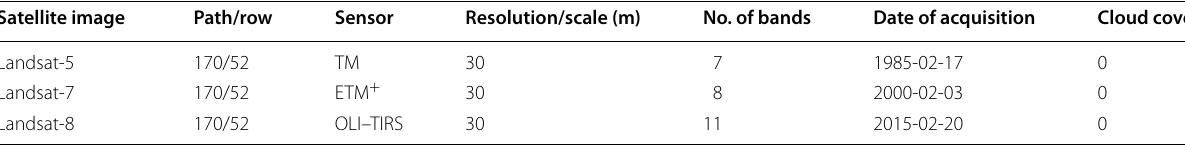
Table 1 Satellite images used for LU/LC change analysis and their characteristics Satellite image